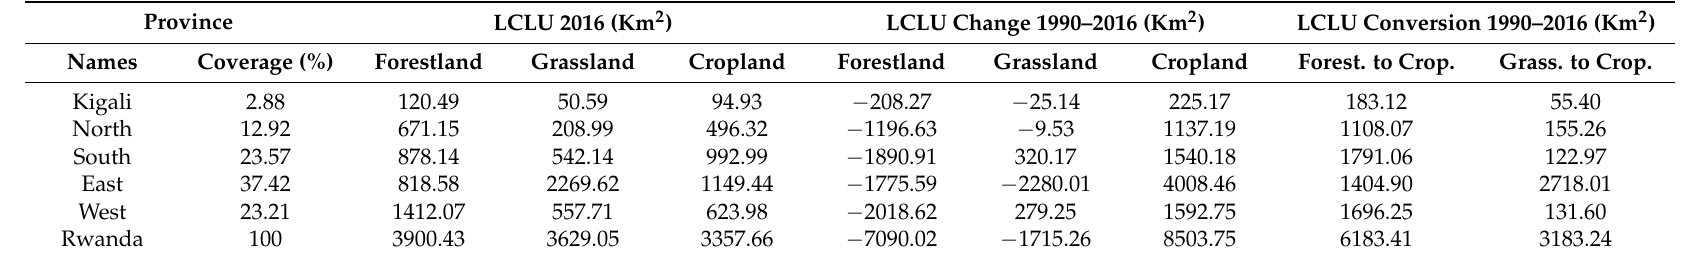
Table A2. Major land cover/use types per province in 2016, their changes and conversions